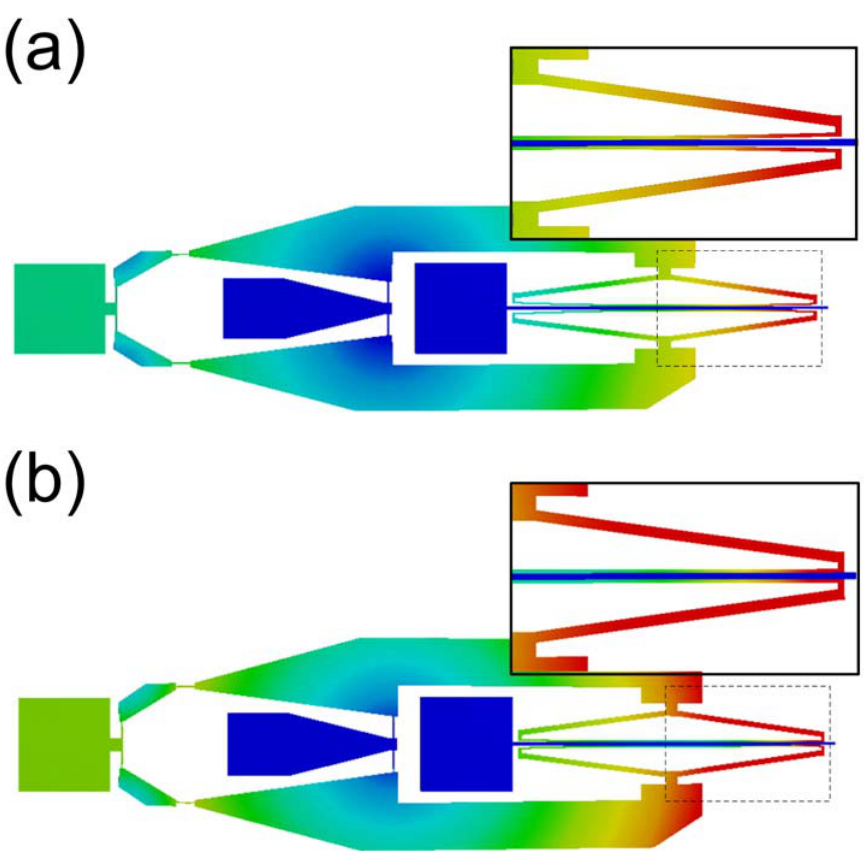
Figure 3. Schematic view of shaft-holding mechanism. ( a ) By the driving force from the chevron thermal actuator, the contact between the shaft-holding flexures and the torsional shaft starts to be formed from the middle of the torsional shaft; ( b ) As the shaft-holder moves further, the shaft-holding flexure is elastically deformed, resulting in a gradual increase in contact area.